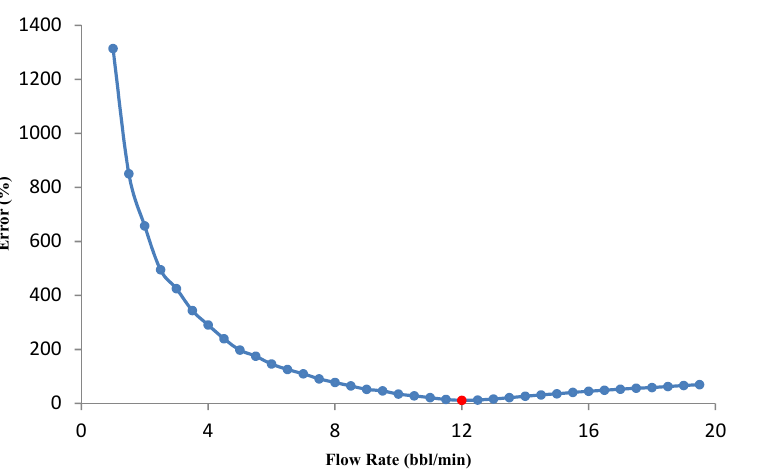
Figure 7. Computational error by changing the injection flow rate for an acid volume of 540 bbl.